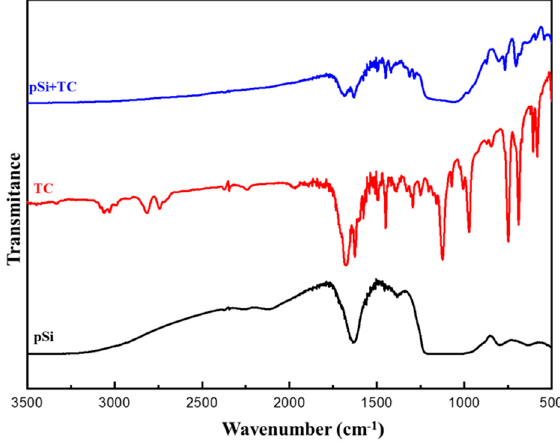
Figure 5. FTIR spectrum of pSi, TC and TC-loaded pSi.